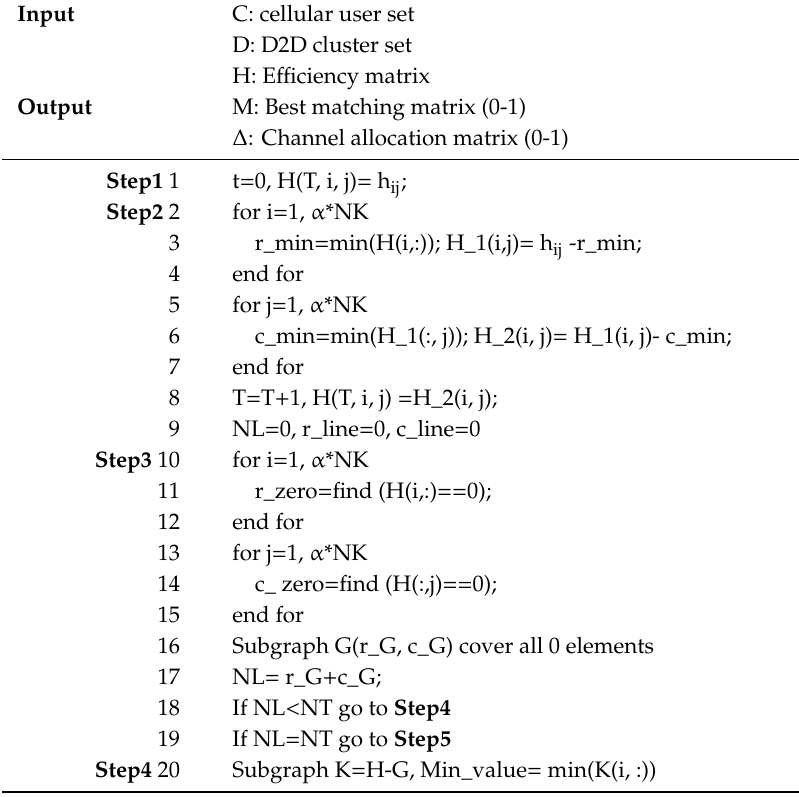
Algorithm 2: Channel assignment based on Hungarian